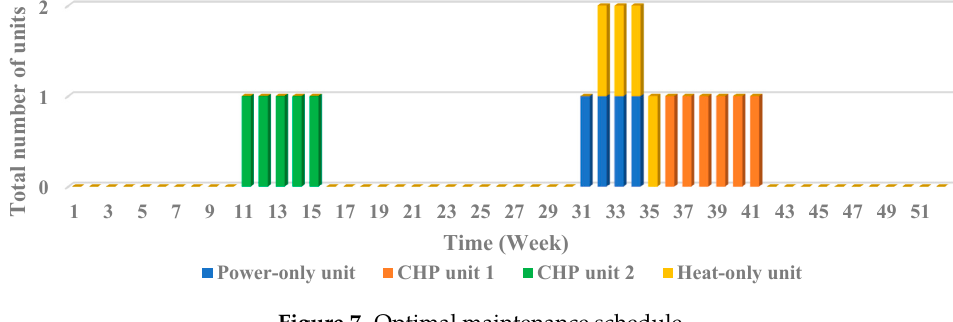
Figure 7. Optimal maintenance schedule.